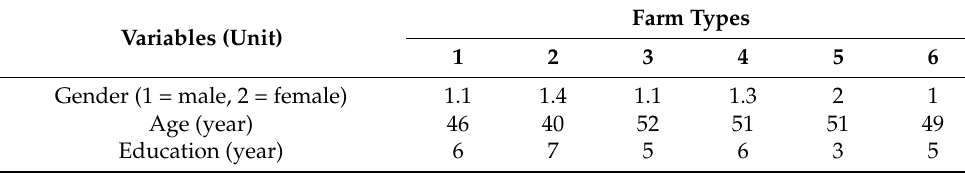
Table 5. Characterization of identified farm types.